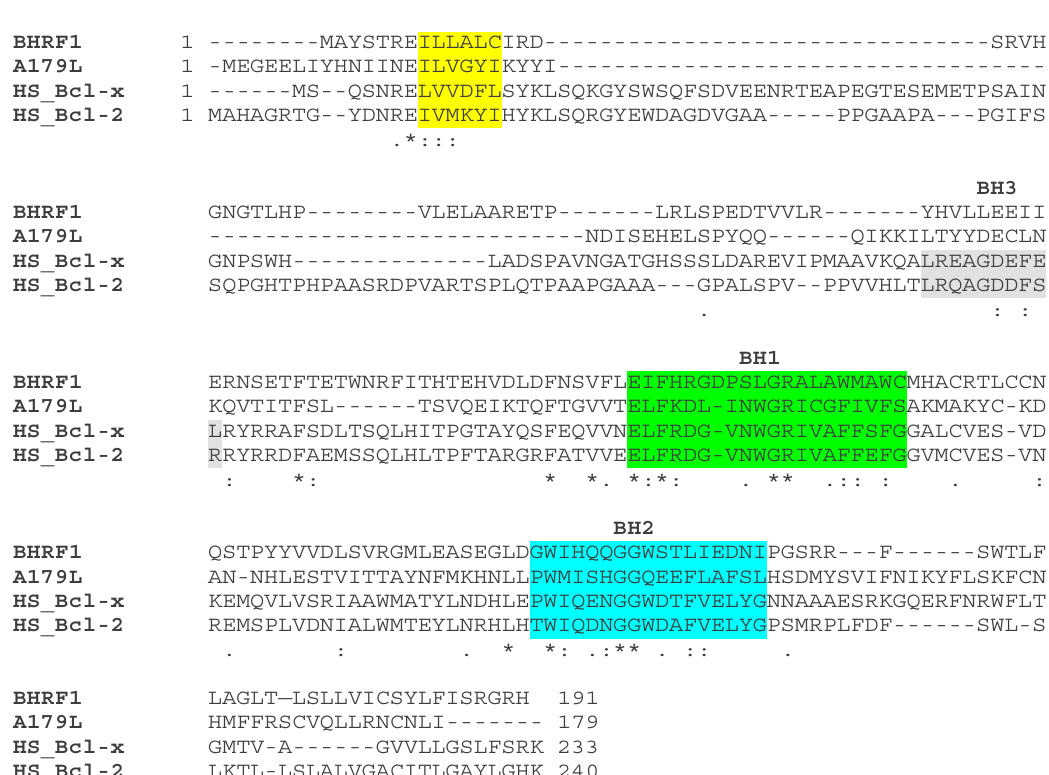
Figure 2. Sequence comparison of ASFV A179L protein with other Bcl-2 family proteins. The ASFV A179L (Interpro annotation P42485) protein sequence was compared with those from EBV BHRF1 (P03182), human Bcl-xL (Q07817) and Bcl-2 (P10415). BH domains are shown as coloured backgrounds. The BH4 domain is shown in yellow, BH3 in grey, BH1 in green and BH2 in turquoise. Amino acid identities between the sequences are shown as asterisks * and similarities as double (:) or single (.) dots. Amended from [30] http://jvi.asm.org/content/91/6/e02228-16.full?sid=d5398579-2b8b-47c3-8fbc-c68ac6dc3ddf.